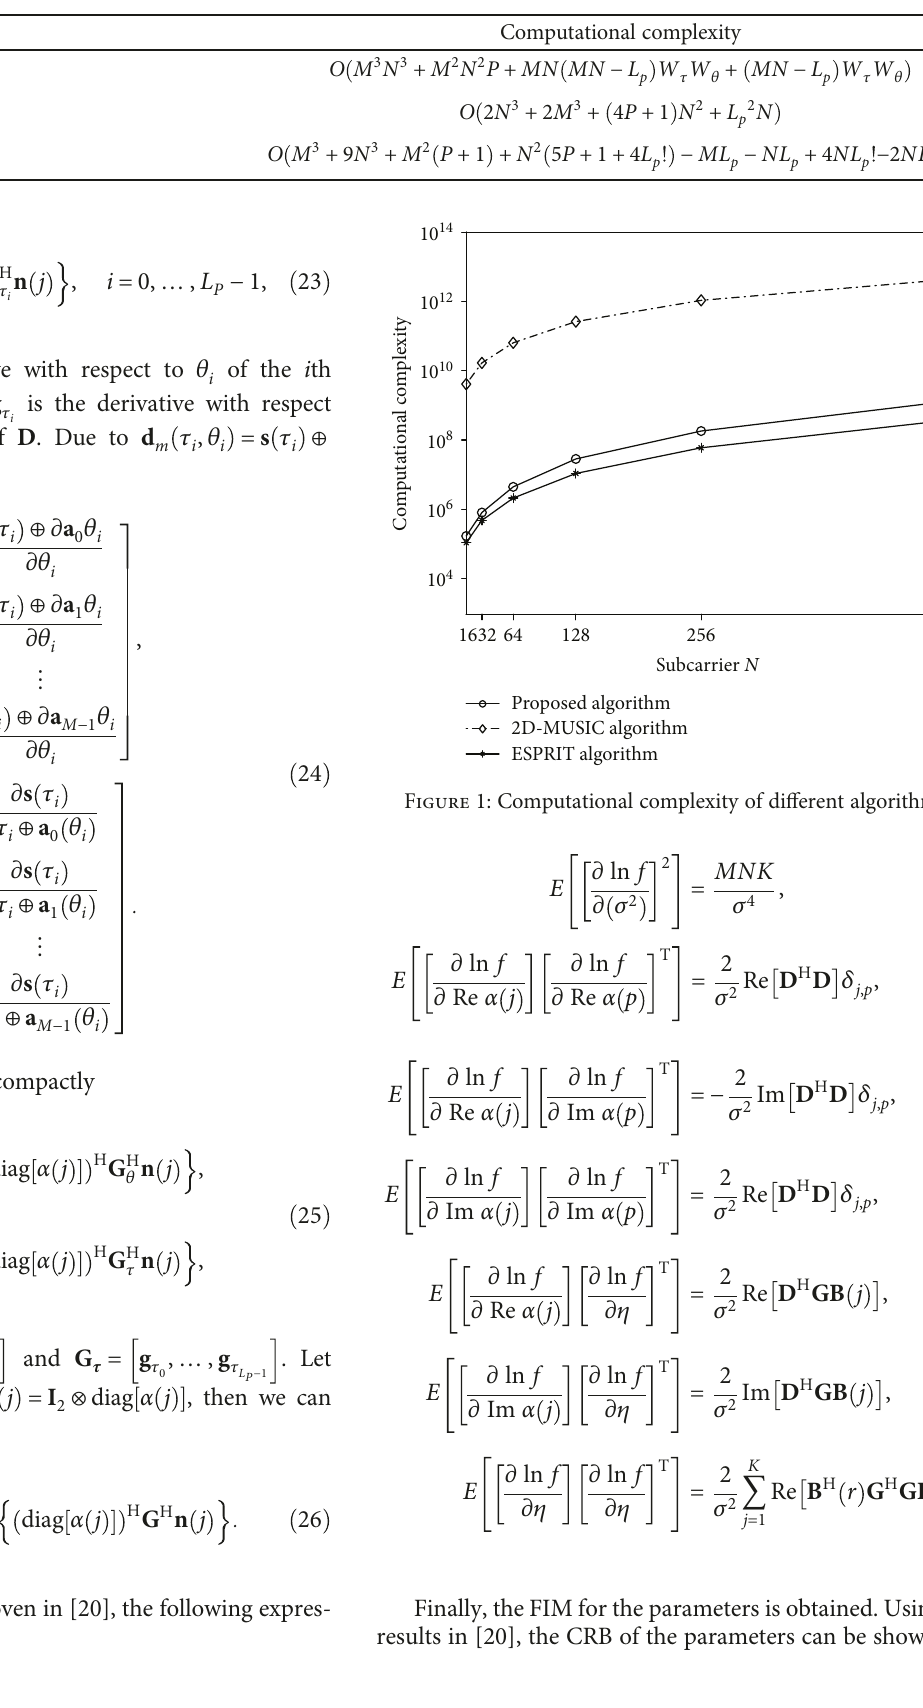
Table 1: Algorithm complexity comparison.